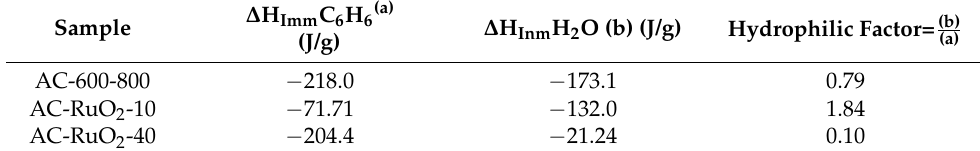
Table 3. Immersion enthalpies in benzene and water and hydrophilic factor of each sample.